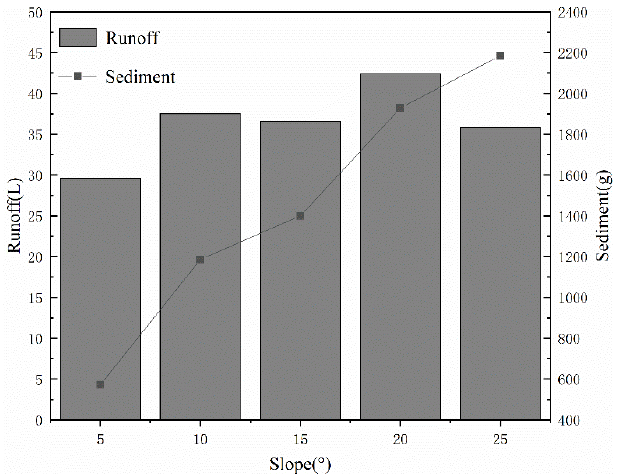
Figure 8. Runoff erosion under different slope gradients.